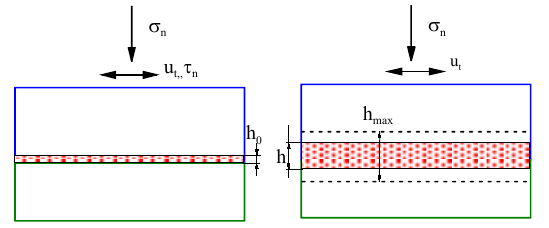
Figure 13: Third body granular layer generation due to cyclic loading